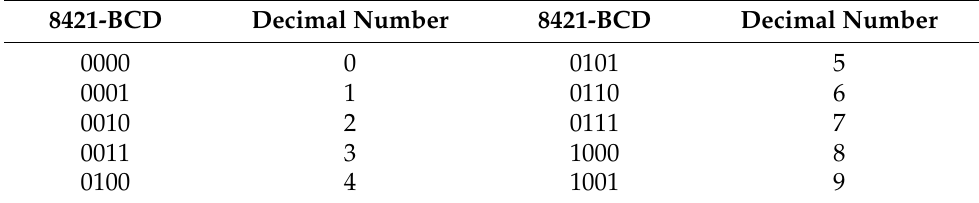
Table 3. The correspondence between 8421-BCD codes and decimal numbers.